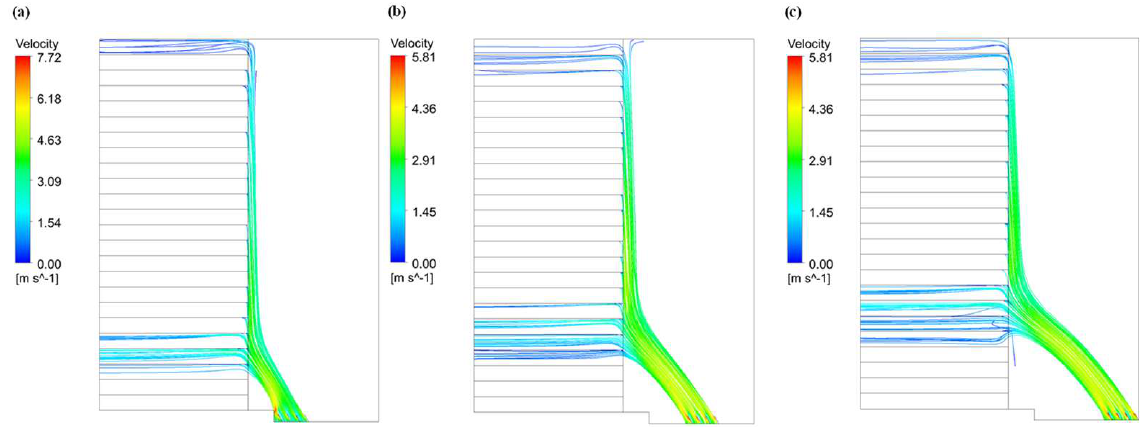
Figure 10. Streamlines of settings ( a ) (60, 0, 0), ( b ) (0, 60, 0), ( c ) (0, 0, 60).